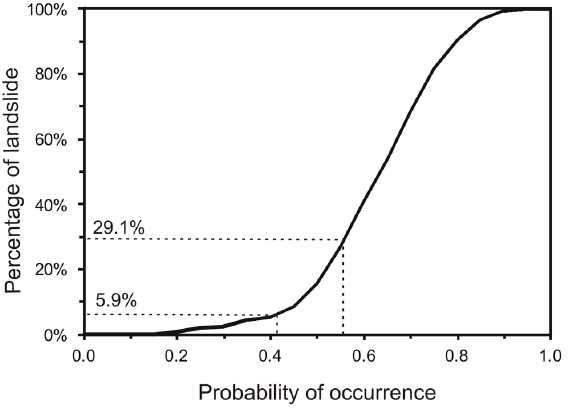
Fig. 7. Analysis of the landslide susceptibility map in the validation area (V) in relation to the distribution of the